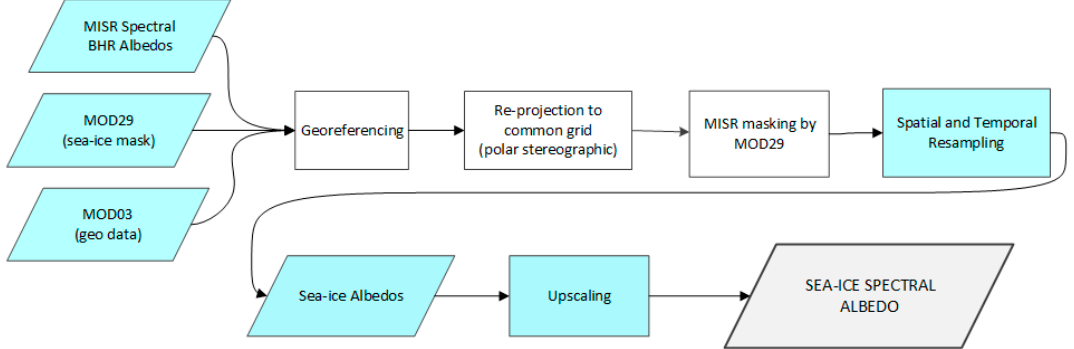
Figure 6 . QA4ECV sea-ice albedo product top-level traceability chain. MISR: multi-angle imaging spectro-radiometer; MOD29: MODIS sea-ice products; and MOD03: MODIS Geolocation Data Set.